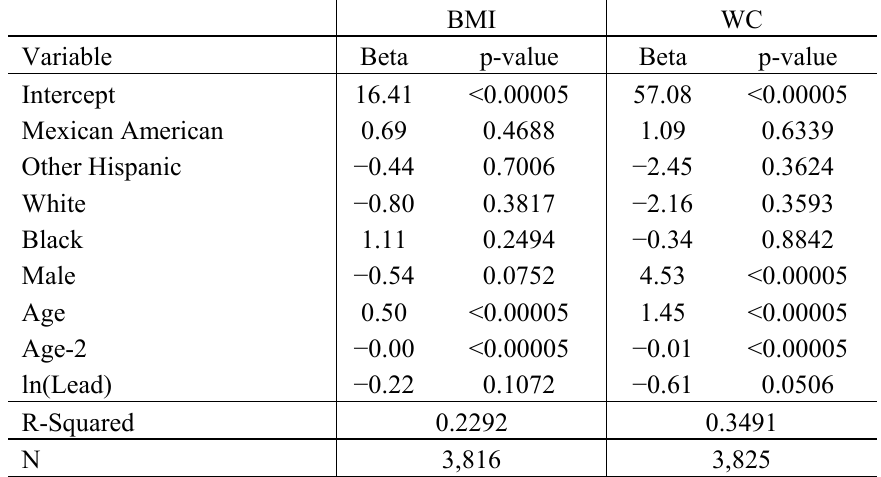
Table 8. Regression for Obesity and Lead Controlling for Model